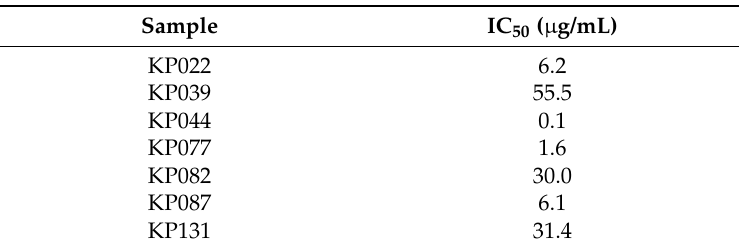
Table 1. IC 50 values of seven metabolite extracts on Caco-2 cells. The values given reduce viability to 50 % after 48 h of exposure.